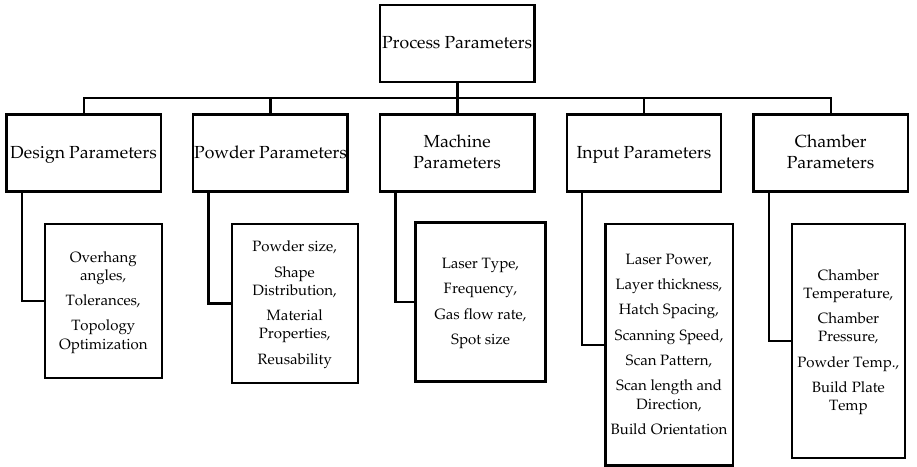
Figure 1. Parameters involved in the powder ‐ based AM.